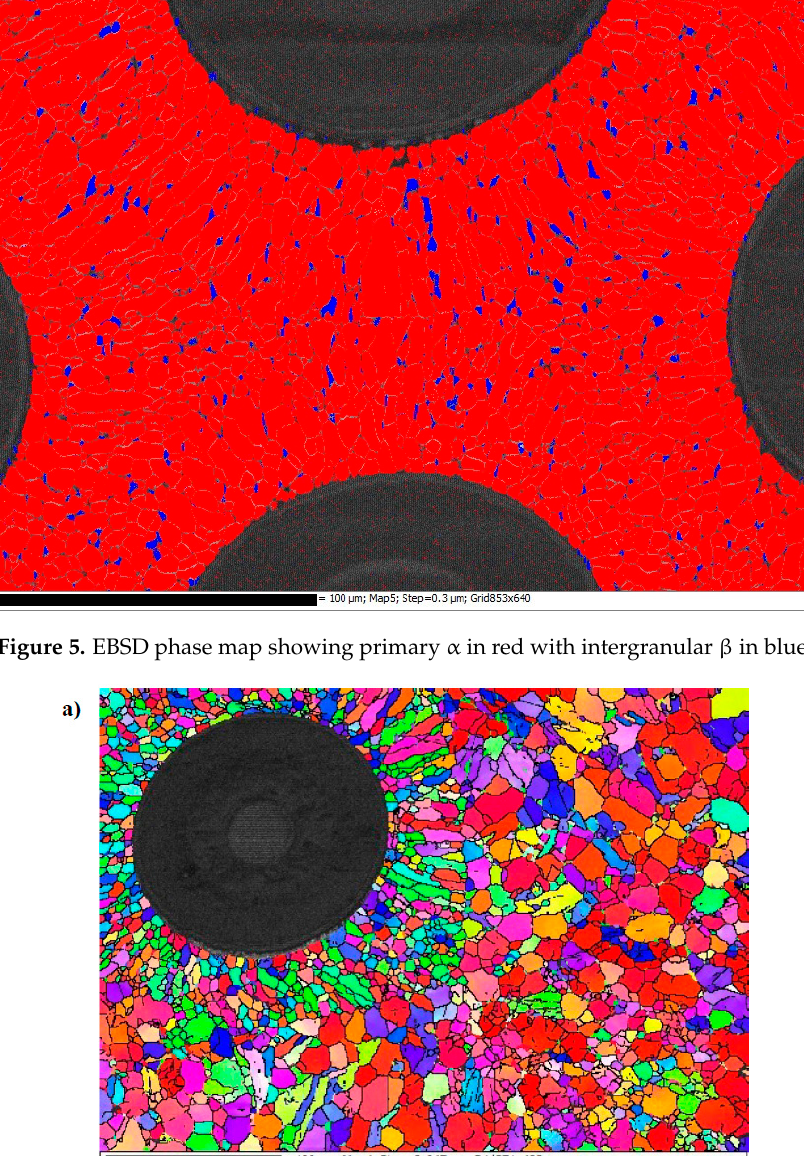
Figure 6. ( a ) Texture map using inverse pole figure colouring indicating grain development as a function of the HIP procedure. ( b ) Pole figures indicating strong basal texture of overall material.